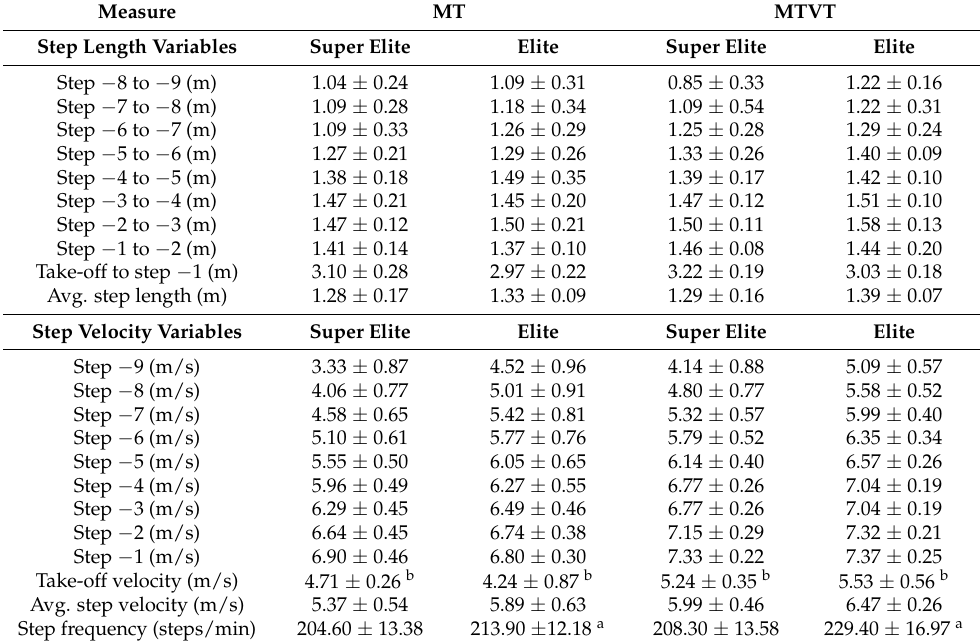
Table 2. The movement behaviour (mean ± SD) for expert and less-expert performers across skills executed using the mini-trampoline without a vaulting table (MT) and with a vaulting table (MTVT).